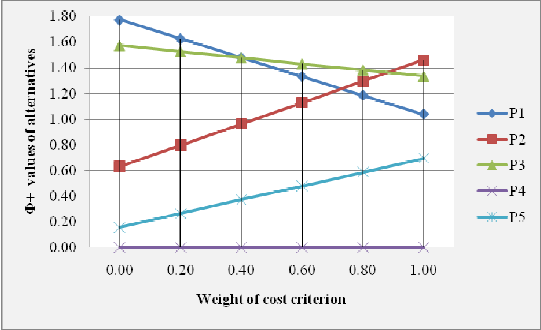
Figure 8. The change in the Φ + values of alternatives with the change in the weight of cost